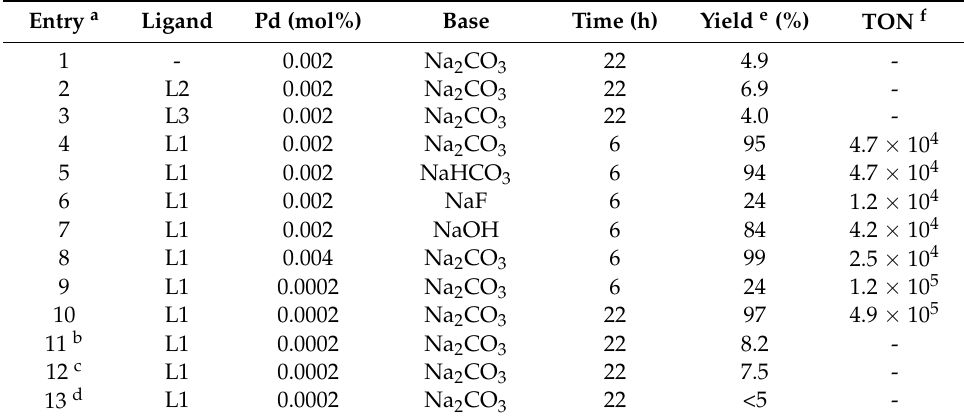
Figure 1. Pd-catalyzed Suzuki-Miyaura cross-coupling reaction of 4-bromobenzoic acid and tetraphenylboron sodium. Table 1. Optimization of reaction conditions.